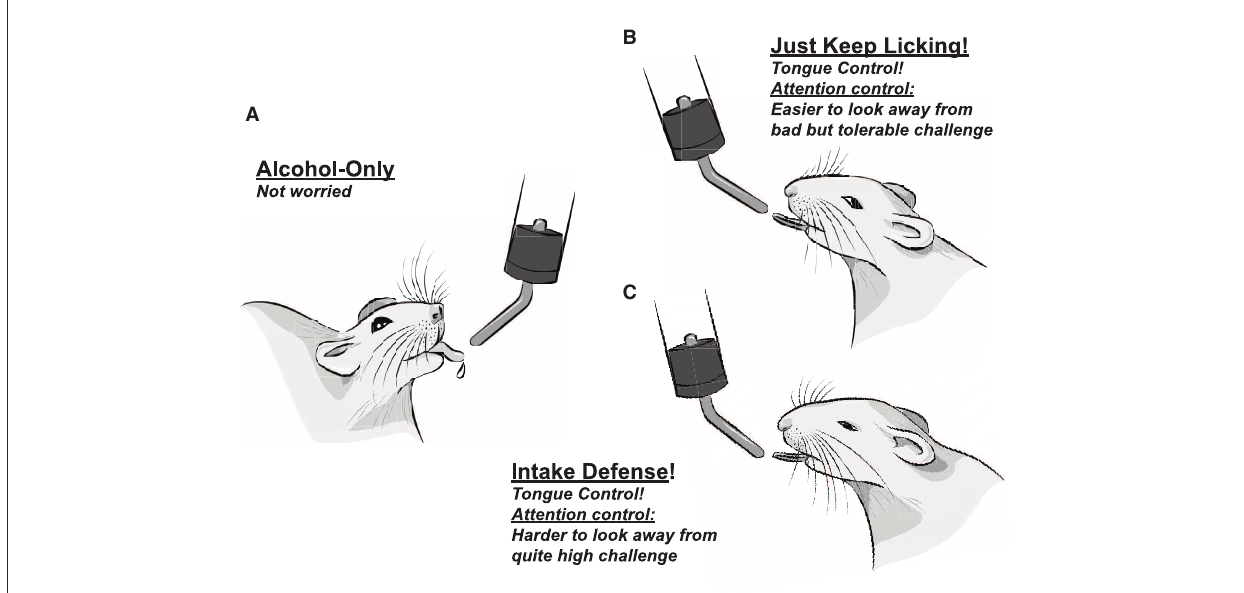
FIGURE2 Somewhat anthropomorphized representations of proposed action, attention, and emotion regulation strategies utilized, including internal mental emotional states, during different rat drinking conditions. (A) Easy, alcohol-only drinking, with no overt adverse challenge. Several clinical groups propose that unchallenged intake recruits a more striatal circuit (22, 58), with less cortical role. (B) Drinking alcohol despite bad but tolerable challenge. Challenged rats show less variable responding in nearly every licking measure, including better control of tongue shape, relative to alcohol-only in (A). This is consistent with focusing on making more automatic, stereotyped actions. At the same time, we have proposed that the rat works to not put attention on the bad consequences (i.e., it successfully distracts itself); together, we call these the Head Down and Push model of responding despite challenge. (C) Drinking alcohol despite quite high challenge (enough to drop drinking by almost half). We propose that higher-challenge CLAD reflects Intake Defense: an idea that came from need to eat some food, even if it is spoiled [discussed in Darevsky et al. (67), Darevsky and Hopf (68) and Kaplan et al. (105)]. The goal is to just start, and push to get “enough” intake. Interestingly, high challenge drinking still shows better tongue control, and early initiation of drinking bouts. Since overall action plan, attentional regulation, and tongue control are